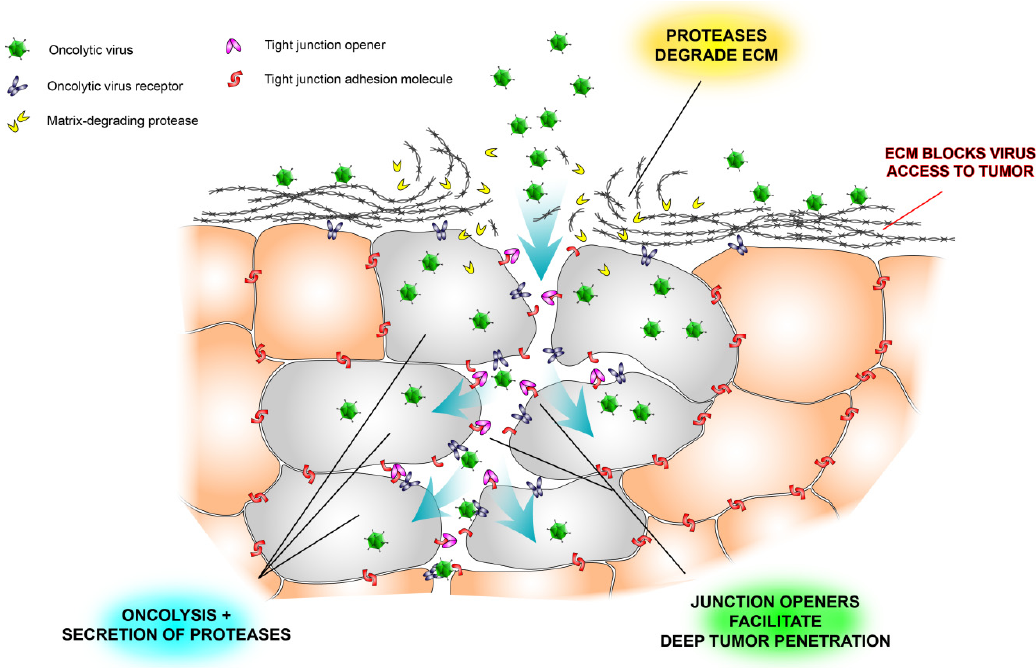
Figure 2. Schematic illustration of some physical barriers to oncolytic viruses and ways to overcome them. Tumor nests are often surrounded by extracellular matrix (ECM), which prevents viruses from reaching the tumor cells (see also Figure 1). Another problem is that tight junctions hide virus receptors and limit diffusion of viruses into the tumor tissue. Newly developed tight junction openers [40,47,48] may facilitate virus infection by exposing the hidden receptors, and virus-encoded proteases may degrade the stromal shield surrounding tumor nests